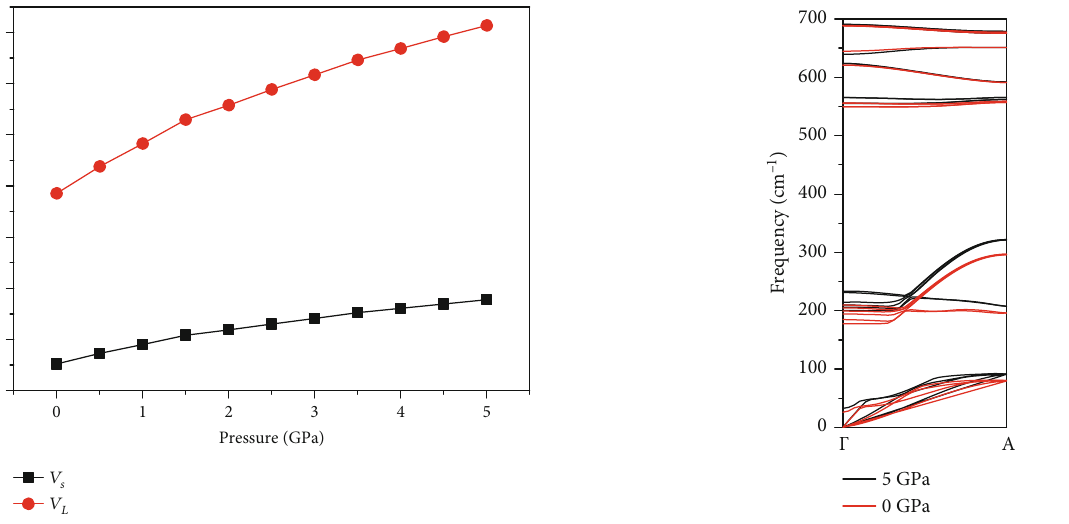
Figure 5: The longitudinal ( V orpiment As